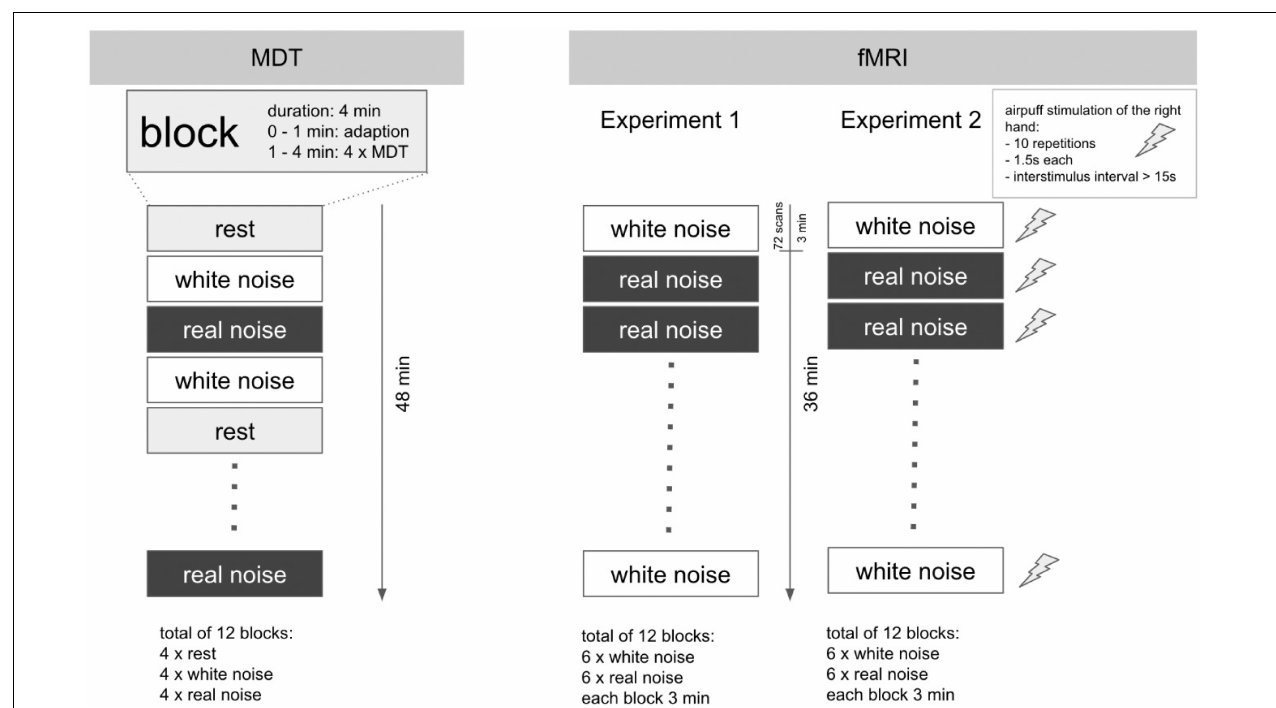
FIGURE 1 | Experimental design for MDT and fMRI experiments. Schematic illustration of the experimental design. Left: MDT: a total of 12 blocks with a duration of 4 min each. The determination of the MDT was performed in each block from the second minute onward (4 × per block). In sum, the study lasted 48 min per subject. Right: fMRI: the experimental setup for Experiments 1 and 2 was in major parts identical. Each of the 12 blocks with acoustic stimulus lasted 3 min. The overall duration per experiment was 36 min. In Experiment 2, however, the fingers of the right hand were additionally stimulated tactilely ( air-puff ) within each block: 10 repetitions, duration 1.5 s, interstimulus interval 15–30 s. In contrast to the MDT determination, no block with rest condition (silence) was performed in the fMRI